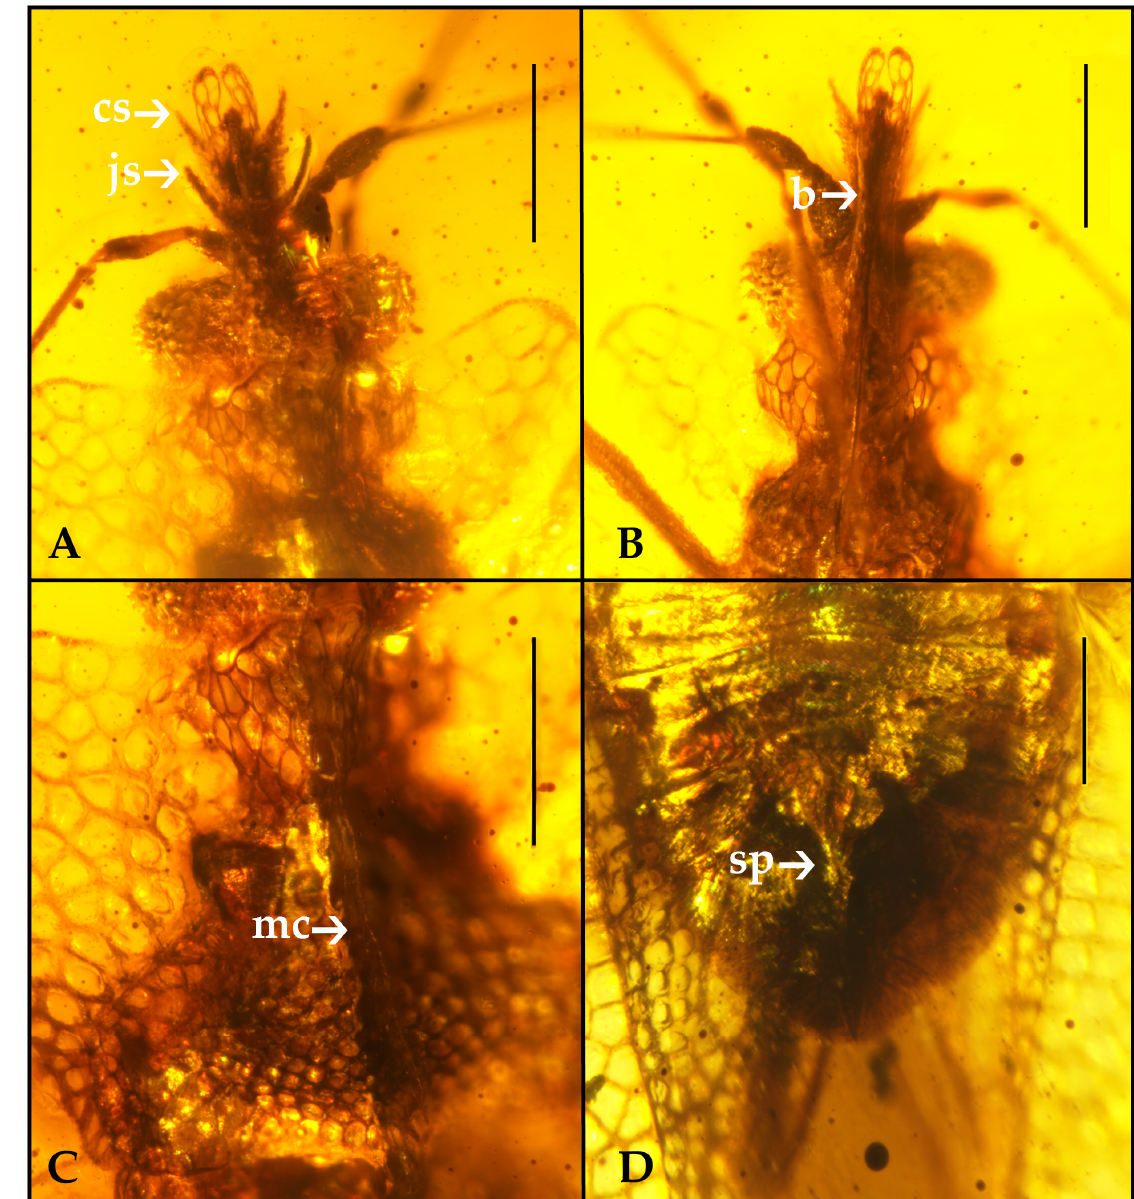
Figure 2. Latidorsum carinbifarium gen. et sp. nov. photographed with morphological details, holotype, CNU-HET- MA2014010. ( A ) head spines. ( B ) bucculae. ( C ) median carina. ( D ) female genital segment. Abbreviations: cs = clypeus, js = jugal spine, b = buccula, mc = median carina, sp = subgenital plate. Scale bars = 0.25 mm.